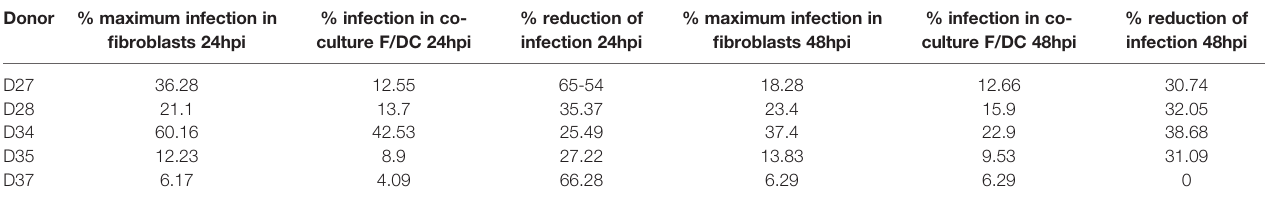
TABLE 1 | Reduction of the infection between the mono-cultures and